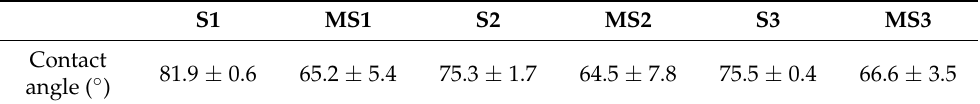
Table 2. Contact angles for the support membranes and their respective TFC FO